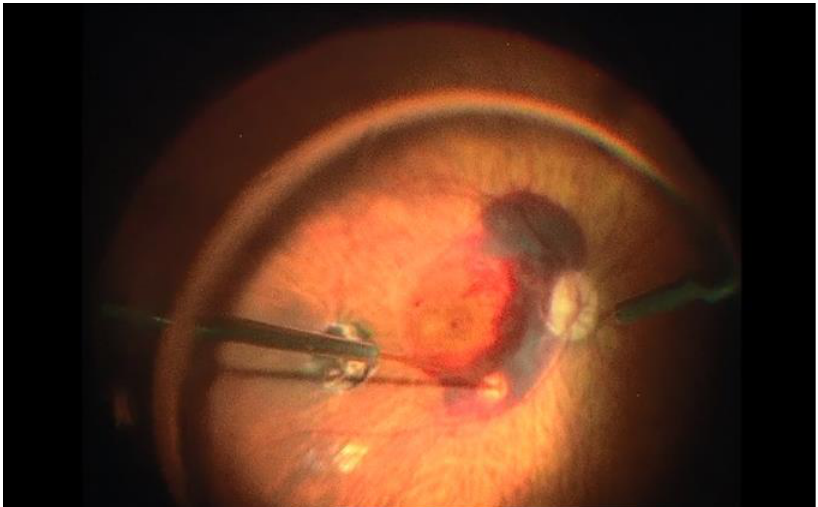
Figure 3 . Subretinal injection of rTPA after pars plana vitrectomy in a case of large submacular hemorrhage associated with age-related macular degeneration. Subretinal injection is performed after internal limiting membrane (ILM) peeling. Note the blanching of the retina when reaching the subretinal